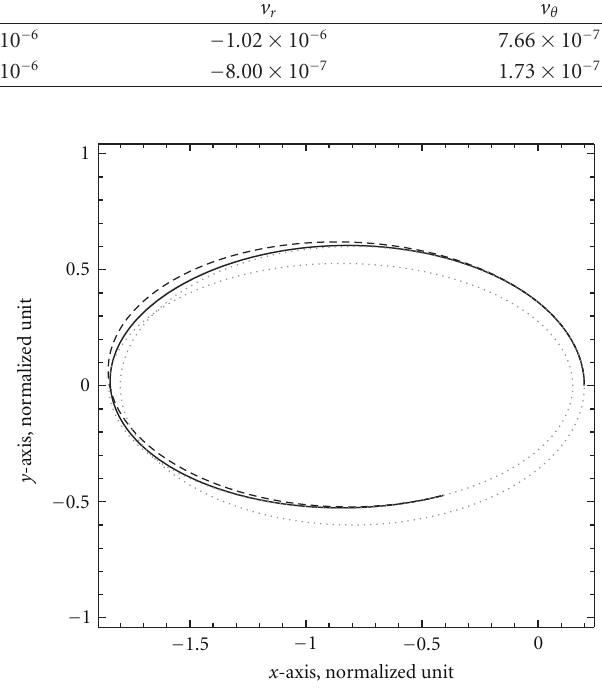
Figure 4: Visual comparison of di ff erent trajectories in case B.